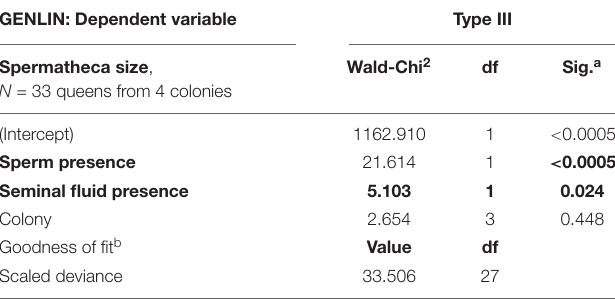
TABLE 3B | Spermathecal sizes (diameters) of Atta colombica queens that had survived an insemination treatment involving sperm ( N = 7 for full ejaculates and N = 5 for sperm only—here pooled for analysis to N = 12) were significantly bigger than those of queens inseminated with seminal fluid ( N = 10) or Hayes saline ( N = 11), here pooled for analysis to N = 21 ( Figure 4B